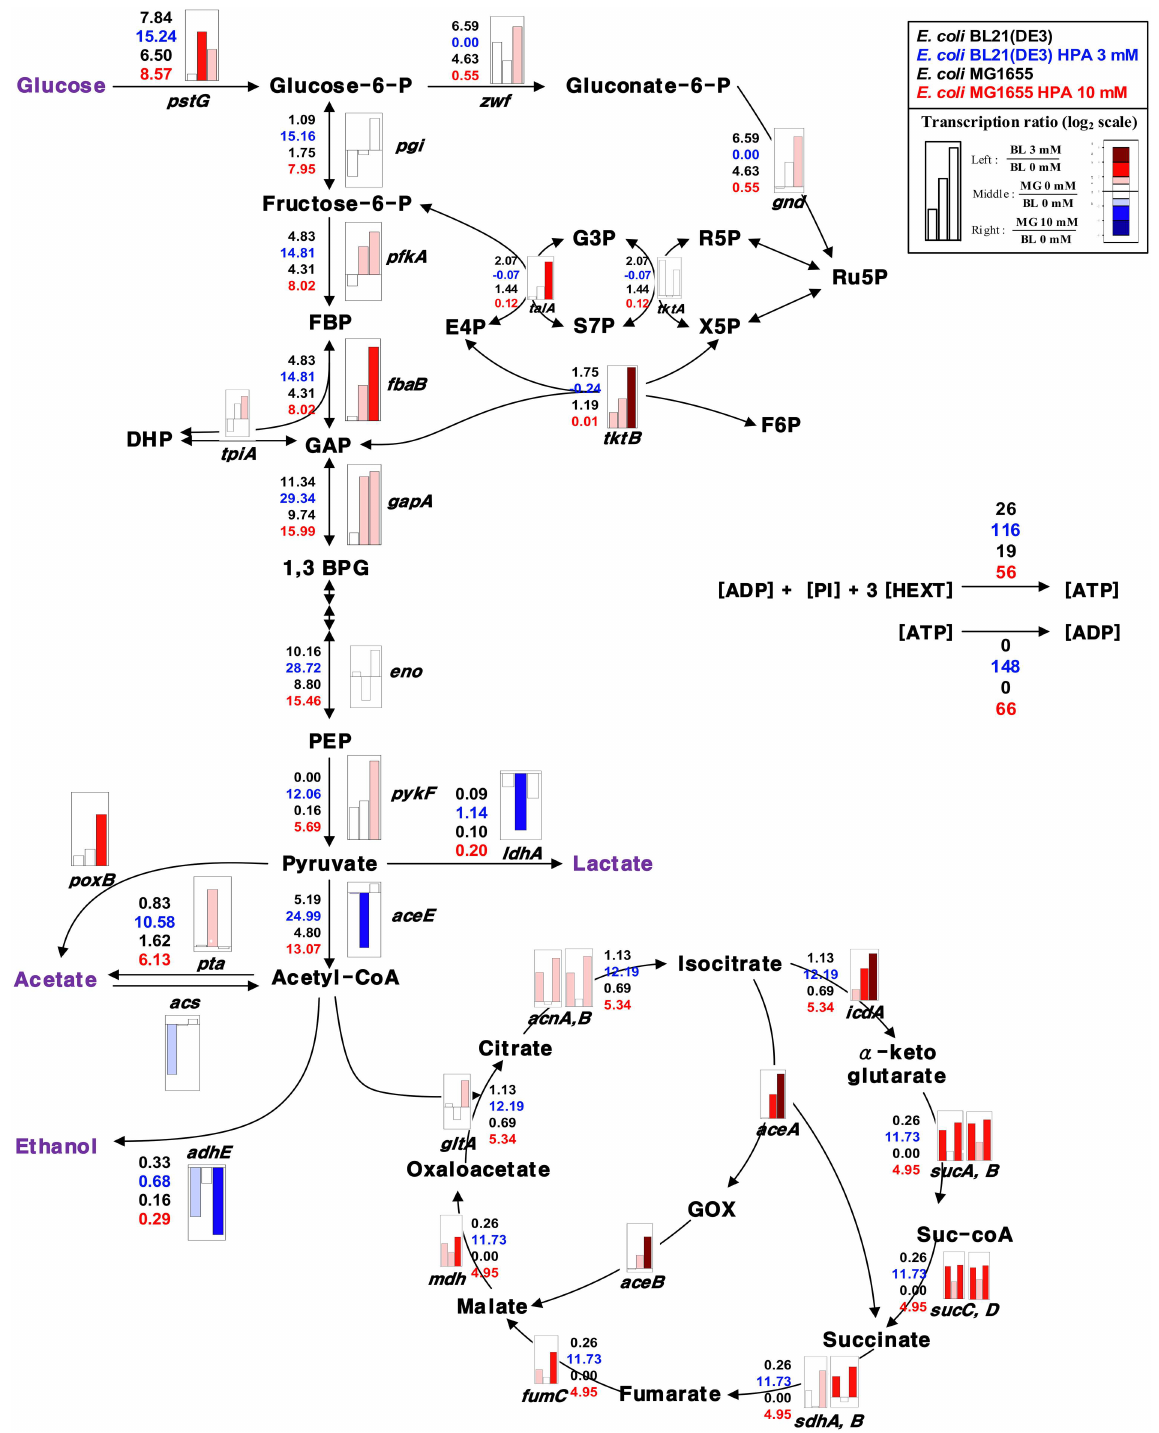
Fig 2. Internal carbon flux distribution in E . coli BL21(DE3) and K-12 MG1655 strains. The cells were grown in the presence of different concentrations of n-heptanoic acid, as shown in Fig 1. The upper values and third upper values indicate the internal carbon flux distribution in E . coli BL21(DE3) and K-12 MG1655 strains growing in the absence of n-heptanoic acid. The second upper values and lower values indicate the internalcarbon flux distribution in E . coli BL21(DE3) and K-12 MG1655 strains growing in the presence of n-heptanoic acid. The BL21(DE3) was cultivated with 3 mM n-heptanoicacid, while the MG1655 was with 10 mM n- heptanoic acid. The heptanoicacid concentration is the concentration, in which the specific growth rate of the E . coli strains